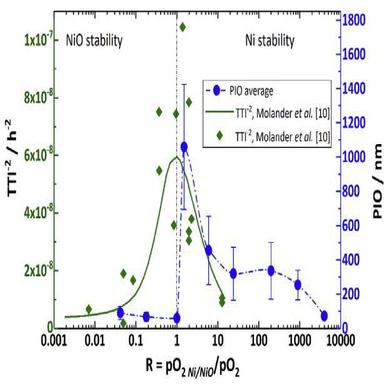
Evolution of the average PIO as function of the oxidizing condition R (eq.. The data from Molander et al. is also plotted as square root of the initiation time (solid green line and green diamonds) so that the dependence of the time-to-initiation and the PIO as a function of the oxidizing condition can be compared. (For interpretation of the references to colour in this figure legend, the reader is referred to the Web version of this article.)